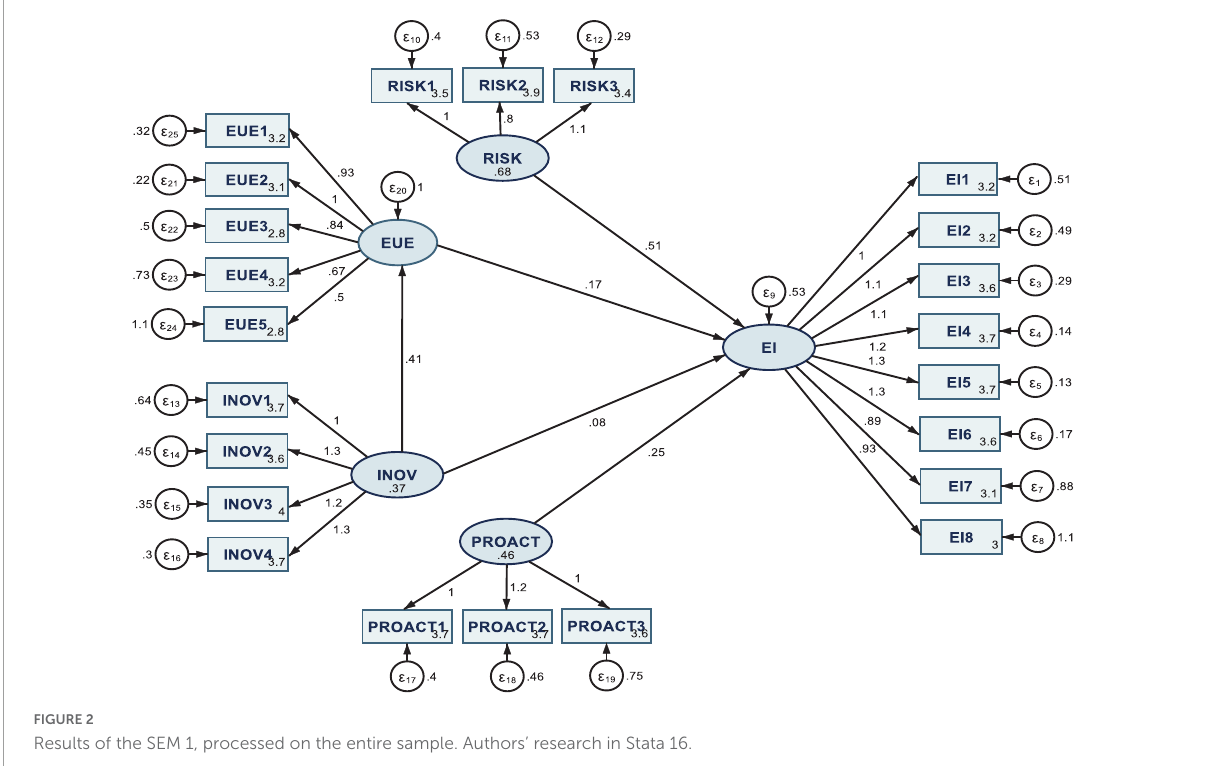
FIGURE2 Results of the SEM 1, processed on the entire sample. Authors’ research in Stata 16.